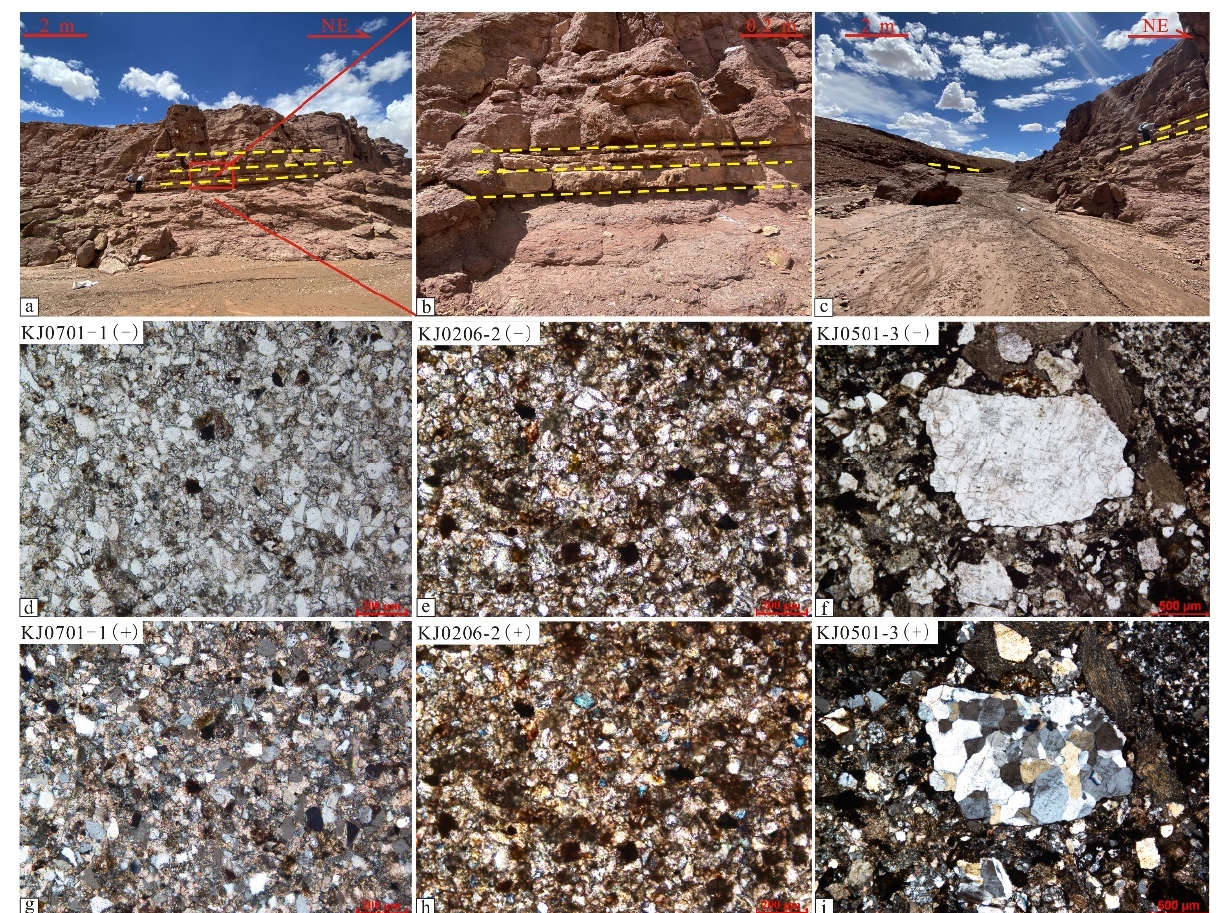
Figure 4. The photo of sandstone minerals and field outcrops in the Jingzhushan Formation on the north side of Nyima County. ( a – c ) Occurrence of field profile; ( d – f ) Minerals photos under the polarising microscope; ( g – i ) Minerals photos under the orthogonal microscope.